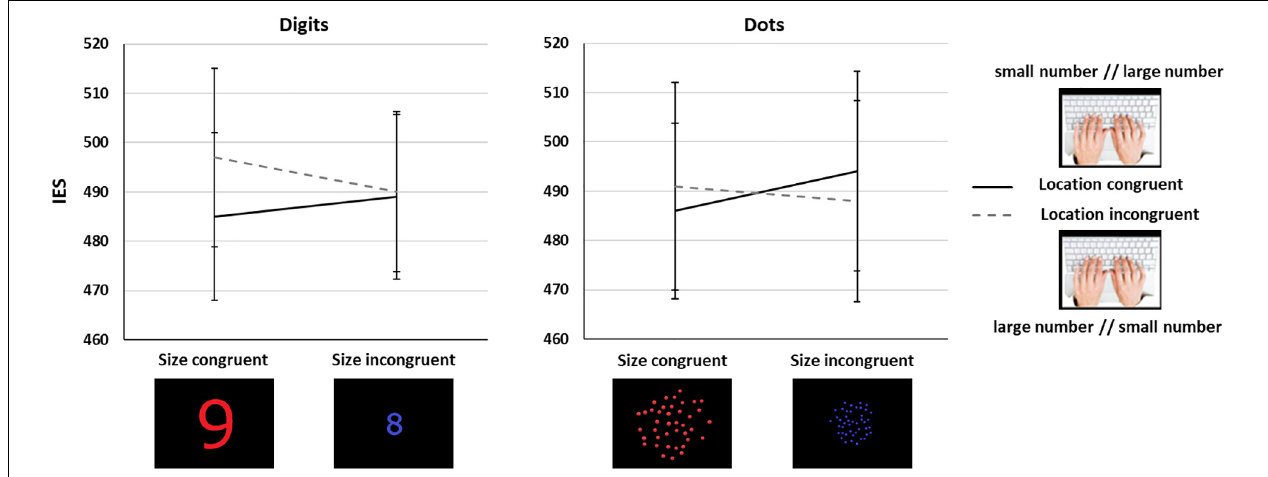
FIGURE 4 | Interaction between number/location and number/spatial extent mappings in Experiment 2 for the symbolic (left) and the non-symbolic (right) tasks. Error bars show standard error of the mean (SEM).